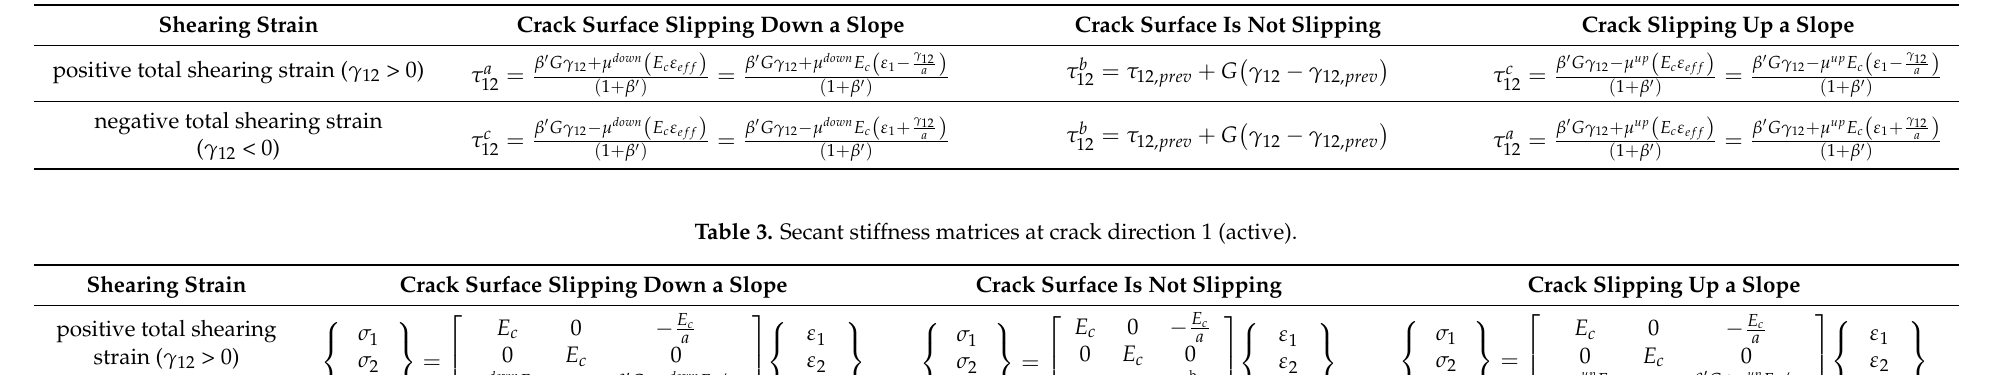
Table 2. Equations for secant stiffness matrices.